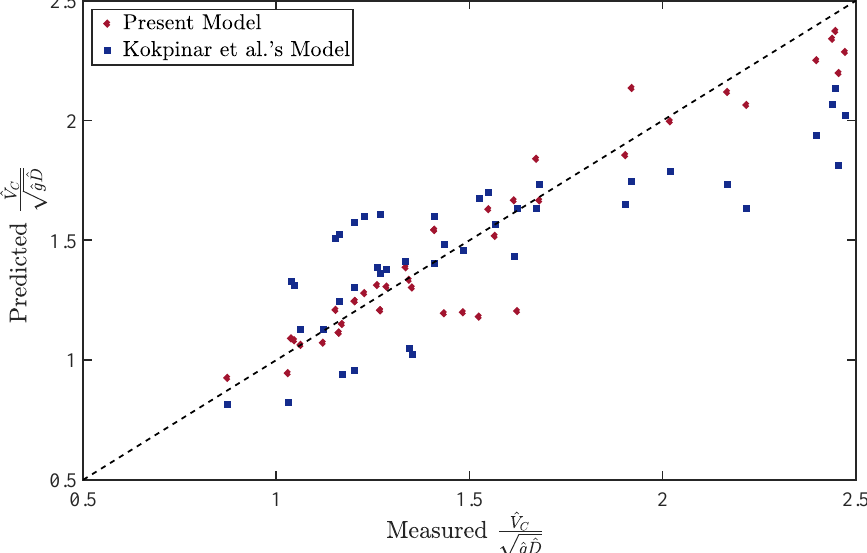
Figure 7. Comparison between dimensionless critical velocity measure experimentally by Kokpinar et al. and the results predicted by their model and the present SVR